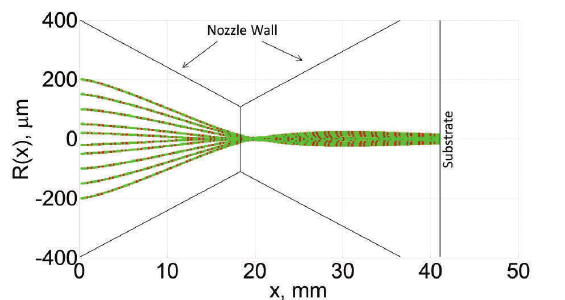
Figure 11. Trajectory of 2 µm diameter silver particles through a converging-diverging nozzle with Stokes and Saffman force applied (solid red), and Stokes, Saffman, and Magnus force applied (dashed green).